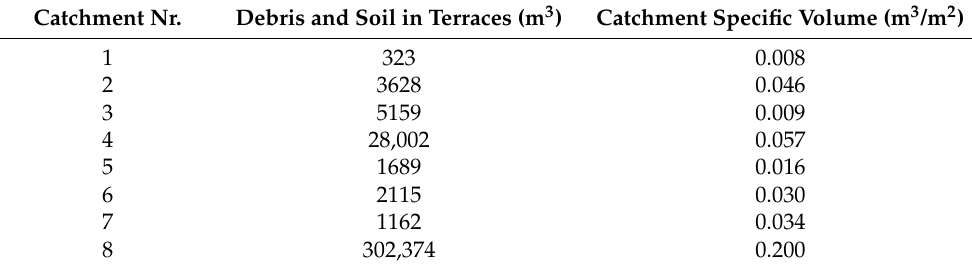
Table 5. The total amount of debris and soil trapped in terraces in the eight studied small catchments. Catchment